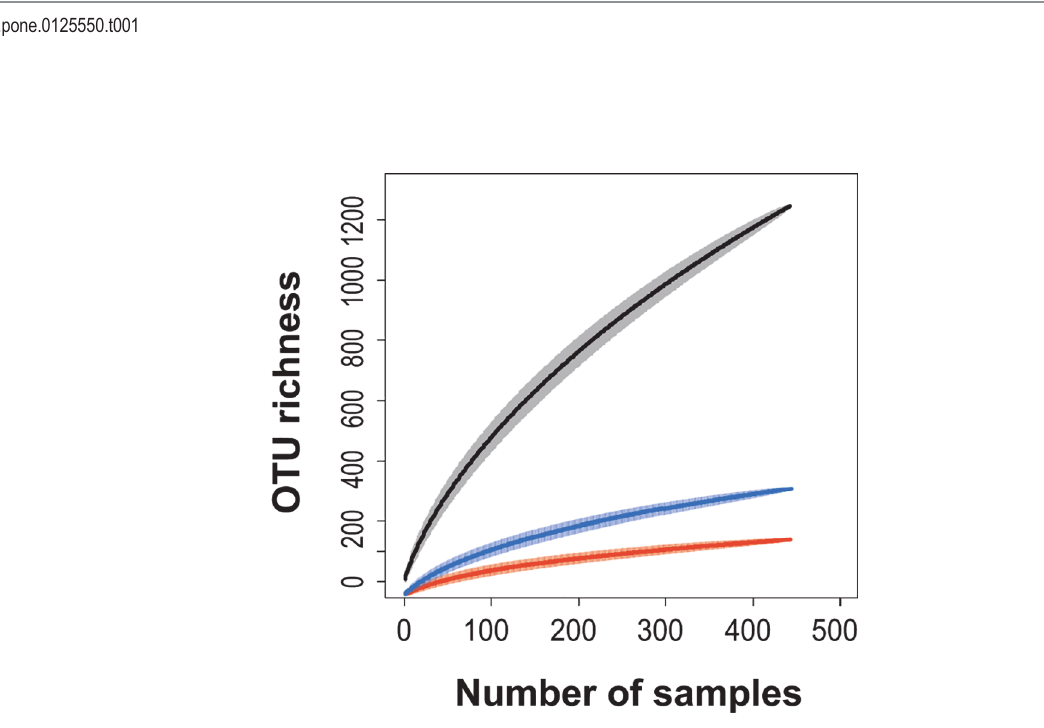
Fig 1. Accumulation curve of operational taxonomic unit (OTU) richness of Ascomycota (black), Basidiomycota (blue), and ectomycorrhizal Basidiomycota taxa (orange) observed in the study site. The shaded areas represent 95% confidence